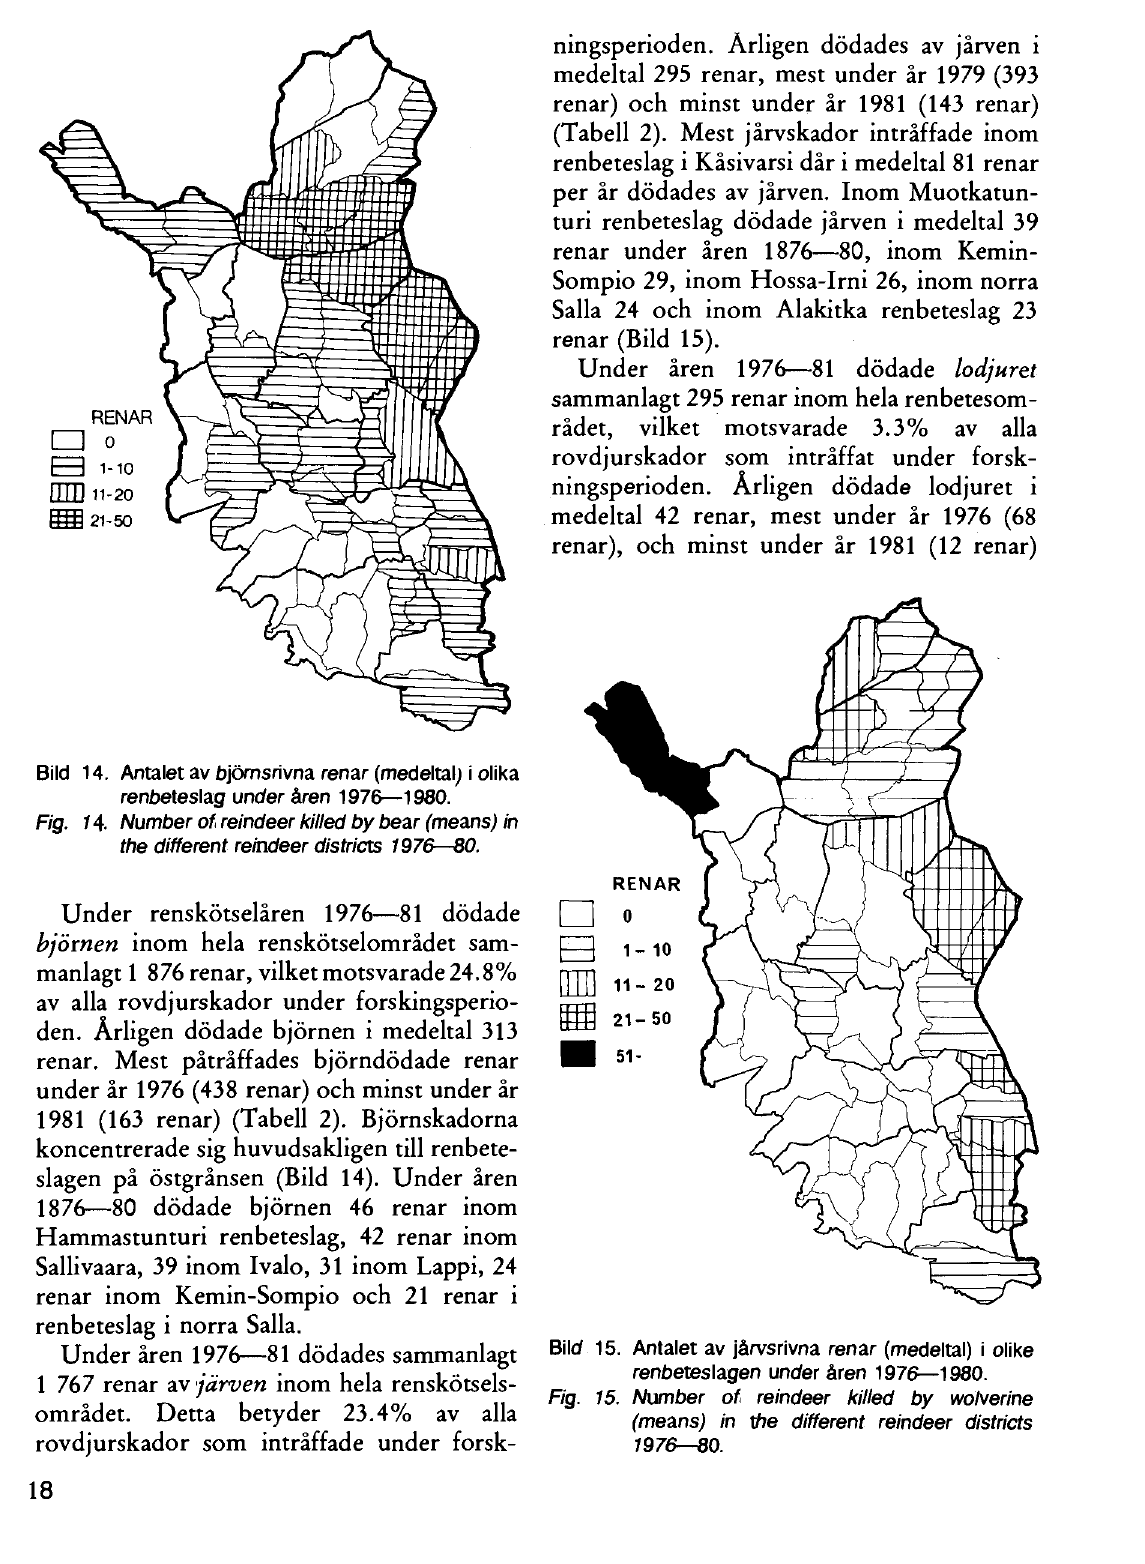
Under renskotselåren 1976—81 doda.de